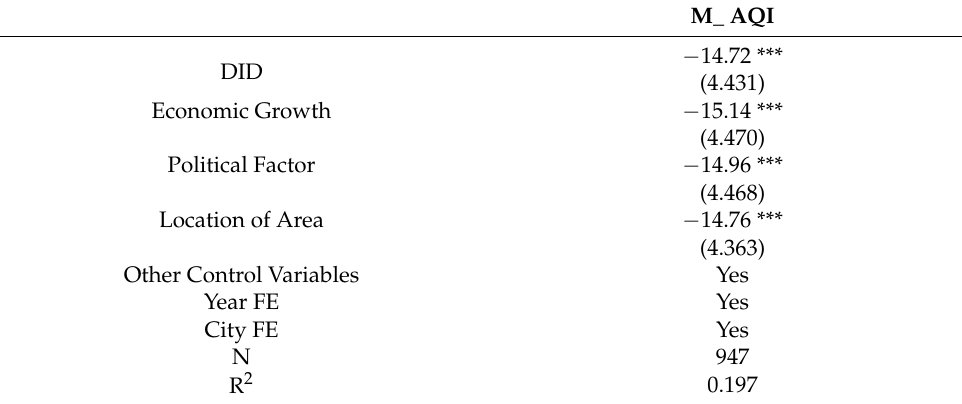
Table 4. Consider the Omitted